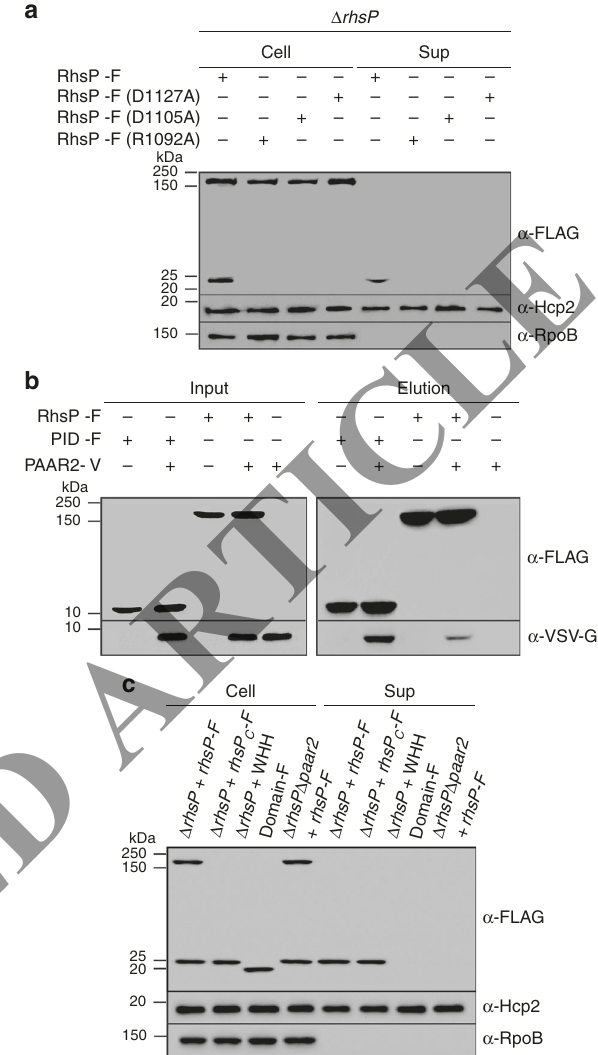
Fig. 3 RhsP C is delivered by binding to PAAR2. a Auto-proteolysis is essential for RhsP C delivery. Mutations that compromised aspartic protease activity abolished RhsP C secretion. FLAG-tagged RhsP (RhsP-F) and individual mutants in RDD (R1092, D1105, and D1127) were expressed from pBAD24 in Δ rhsP and the secretion of RhsP and its derivatives were examined by Western blot analysis of the total (Cell) and secreted proteins (Sup). b Validation of interaction between PAAR2 and PID with Co-IP. Epitope-labeled RhsP-F (pBAD24- rhsP-F ), PID-F (pBAD24-PID-F), or PAAR2-V (pBAD24- paar2-V ) was expressed in E. coli DH5 α . PAAR2 tagged with VSV-G (PAAR2-V) was immuno-precipitated by FLAG-tagged RhsP (RhsP-F) or FLAG-tagged PID (PID-F). c PID is essential for RhsP C secretion. Western blot analysis of cell lysate (Cell) and supernatant proteins (Sup) of FLAG-tagged RhsP (RhsP-F) and its truncated derivatives (RhsP C -F or WHH domain-F) expressed in Δ rhsP or Δ rhsP Δ